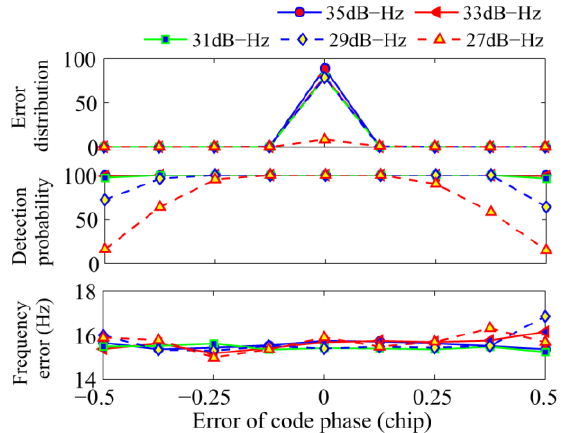
Figure 9. Performance of the proposed algorithm against the code phase error.